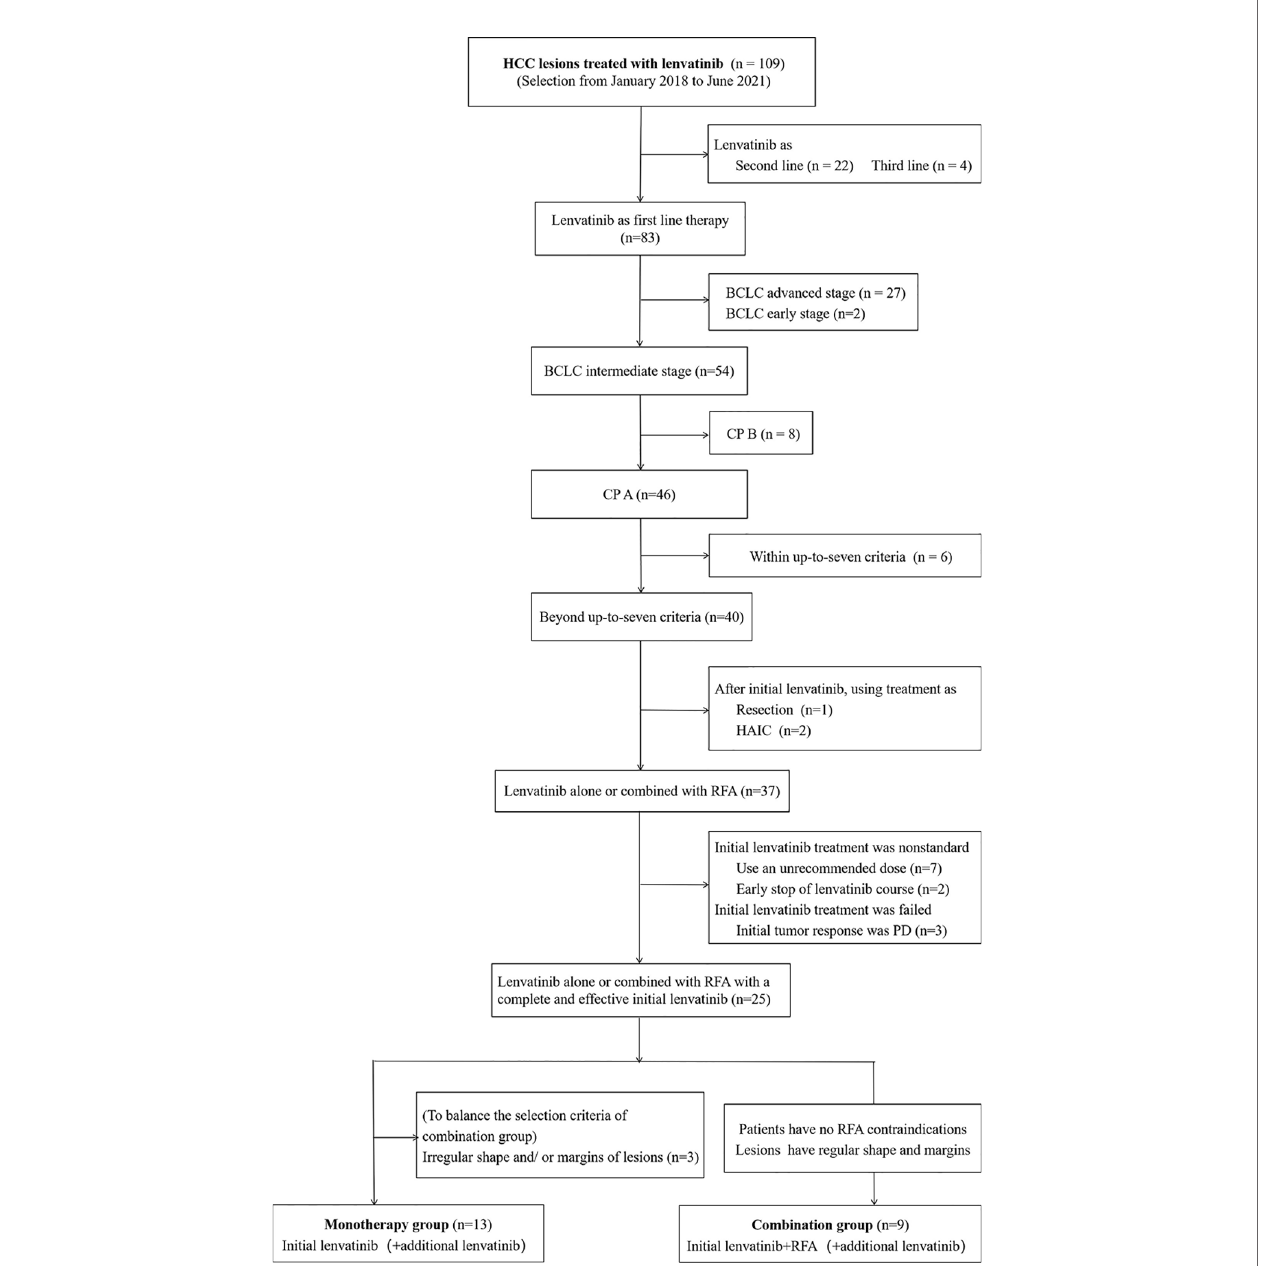
FIGURE 1 | Flowchart of the study population. HCC, hepatocellular carcinoma; BCLC, Barcelona Clinic Liver Cancer; CP, Child – Pugh; HAIC, hepatic arterial infusion chemotherapy; RFA, radiofrequency ablation; PD, progressive